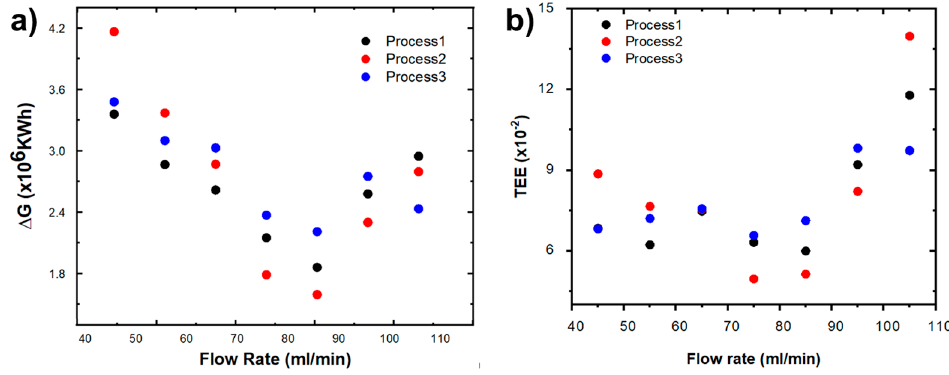
Figure 8. ( a ) Gibbs free energy and ( b ) Thermodynamic energy efficiency for the three types of processes as a function of flow rate (NaCl 0.4 M, 1.2 V). Table 5. Gibbs free energy of separation and thermodynamic energy efficiency calculated for various flow rates using three different types of processes (NaCl 0.4 M, 1.2 V).